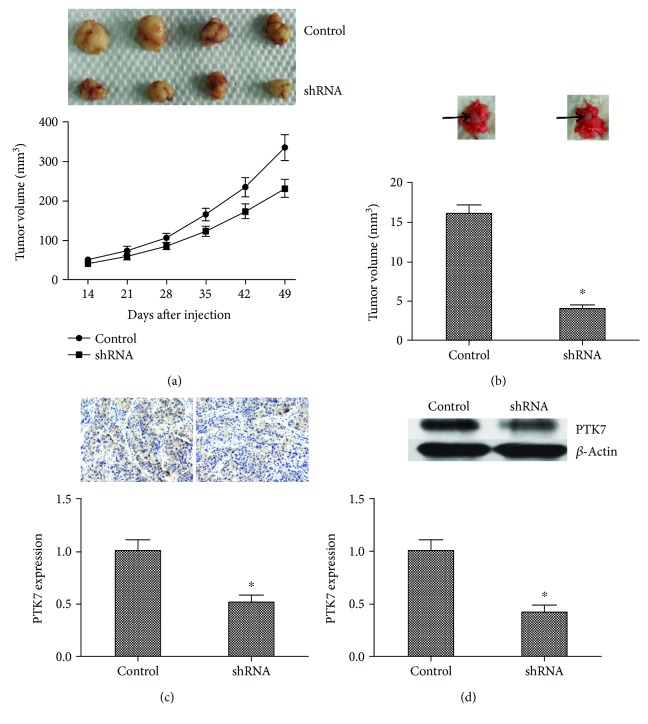
PTK7-depleted cells inhibit cervical cancer growth in vivo. (a, b) Xenograft assay. The tumor volume of the PTK7 knockdown group was significantly smaller than that of the control, after 4 weeks of management (∗P < 0.05). (c, d) PTK7 protein level was dramatically decreased in the PTK7 knockdown group of injected tumor xenografts in nude mice by IHC and Western blot assays (∗P < 0.05).